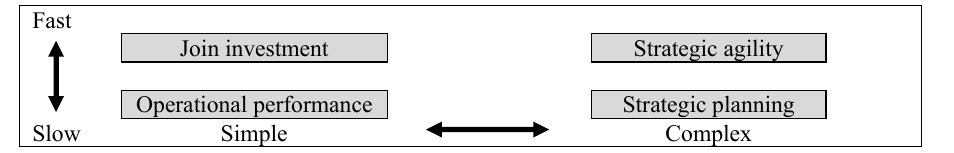
Fig. 1. The relationship between the speed and nature of change (Doz & Kosonen,